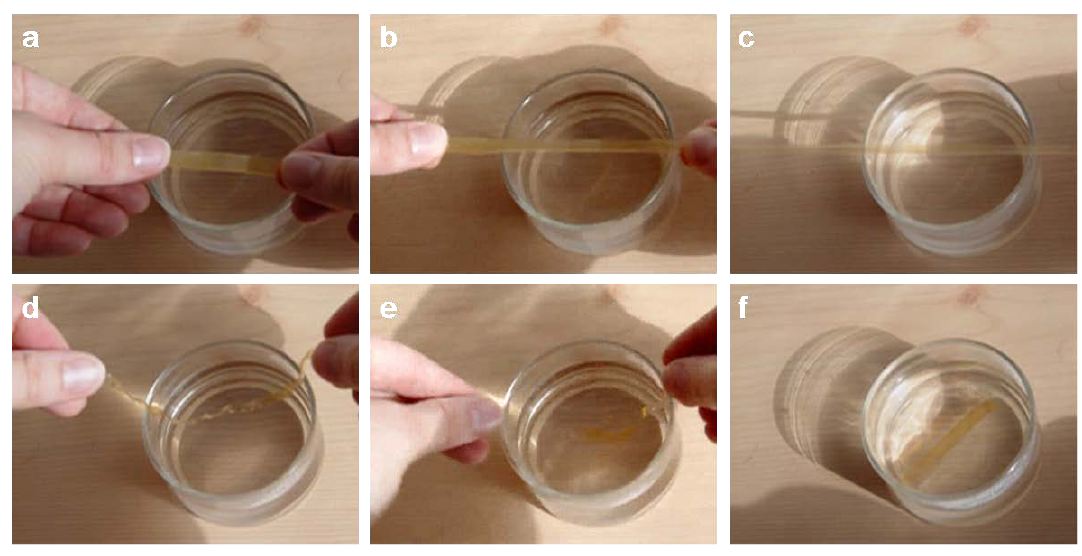
Figure 7. (a)–(c) A thin strip of shape-memory polymer P11 was stretched at ambient temperature to several times its original length. (d)–(f) Immersion of the stretched film in a warm water bath (kept at 60 °C) resulted in the film recovering its original